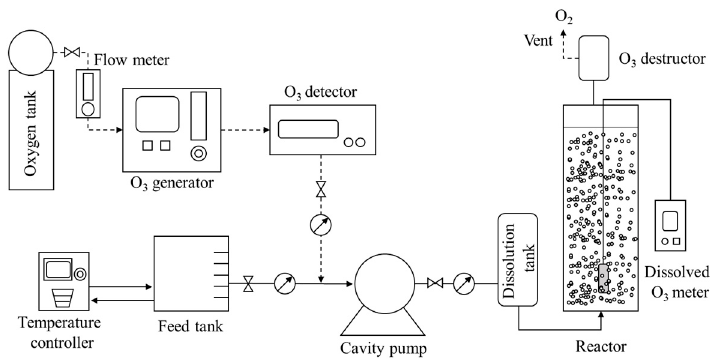
Figure 1. The schematic diagram of the lab-scale microbubble ozonation process.